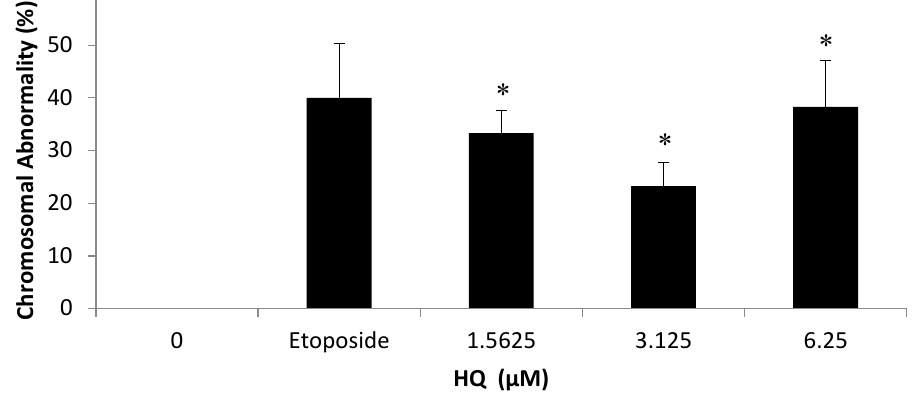
Figure 7 Effect of HQ exposure on the chromosomal aberration status of murine bone marrow-derived HSCs following 24 h exposure to HQ and Etoposide. Data are presented as the mean ± S.E.M (n = 3). * p < 0.05 compared with the control